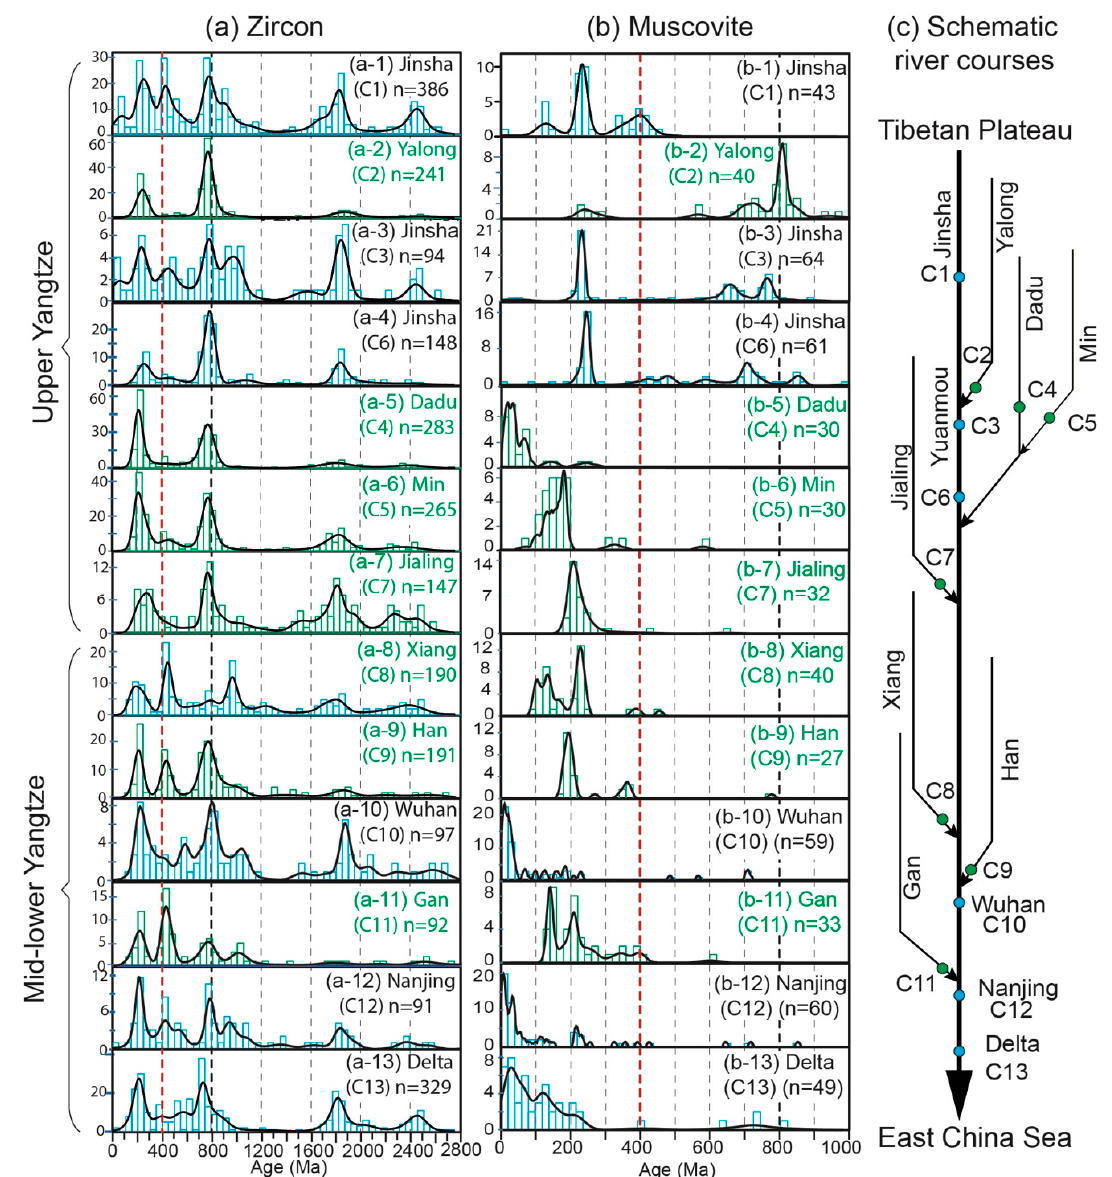
Figure 4. Comparison of age distributions between detrital zircons ( a ) and muscovites ( b ) of modern sands of the Yangtze. ( c ) Schematic river course of the Yangtze. Note the difference in age scale between muscovite (0–1000 Ma) and zircon (0–2800 Ma). The dashed vertical red and black lines mark 400 and 800 Ma, respectively. The histogram diagrams in blue and green are samples from the main stream and major tributaries, respectively. Detrital zircon data from He et al. [21] and Yang et al. [26]. Detrital muscovite data from Sun et al. [16,24] and Hoang et al. [25].